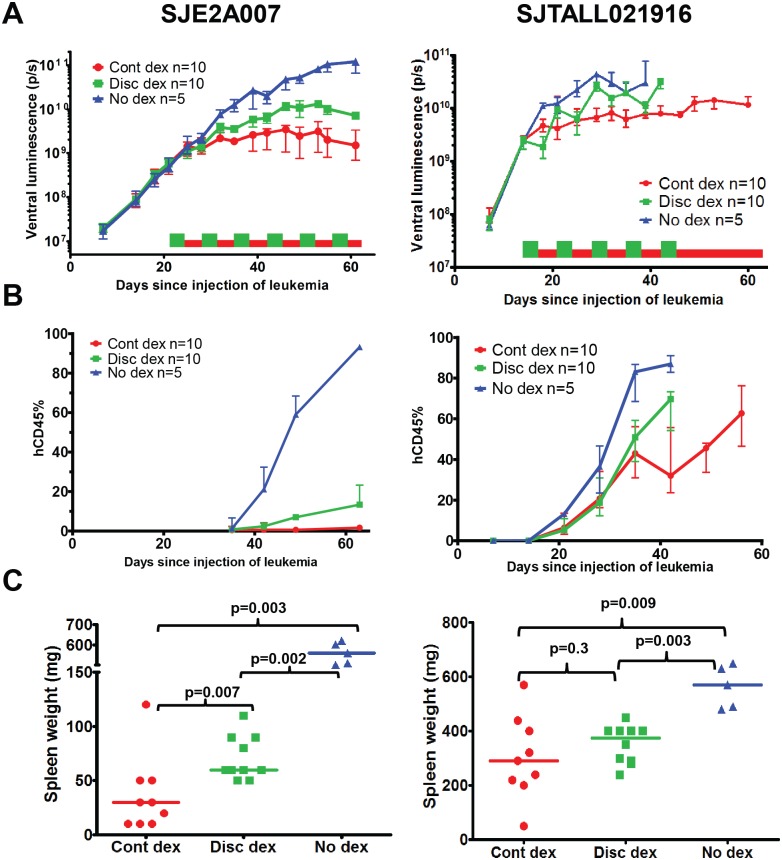
Continuous dexamethasone was more effective than discontinuous dexamethasone for SJE2A007 cells but not SJTALL021916 cells.Red indicates continuous dexamethasone (Cont dex), green indicates discontinuous dexamethasone (disc dex), and blue indicates no dexamethasone. A, ventral luminescence over time. Symbols indicate median luminescence and error bars indicate interquartile range. Red and green boxes near the x-axis indicate treatment period (continuous dexamethasone in red, discontinuous dexamethasone in green). B, hCD45% in the blood over time. Symbols indicate median and error bars indicate interquartile range. C, spleen weight on day 62 (SJE2A007, left) or at the time of sacrifice (SJTALL021916, right). Symbols indicate individual mice, and horizontal line indicates median. P values were calculated with a two-tailed Mann Whitney test.